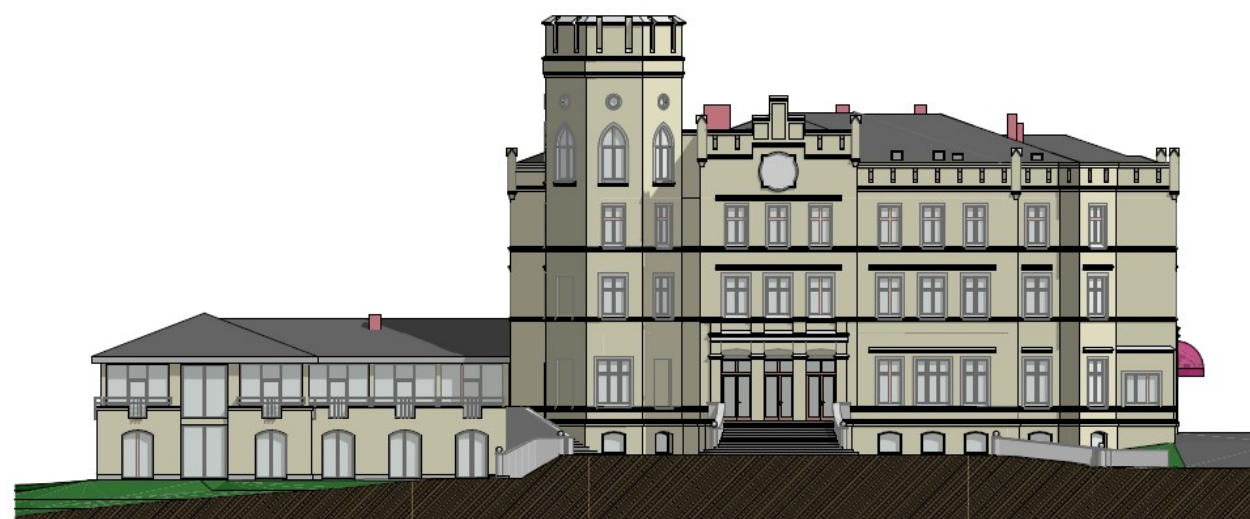
Figure 8. View of the southern façade of the Palace in Maciejewo. Drawing by: Urbicon Spó ł ka z o.o. Szczecin; author.